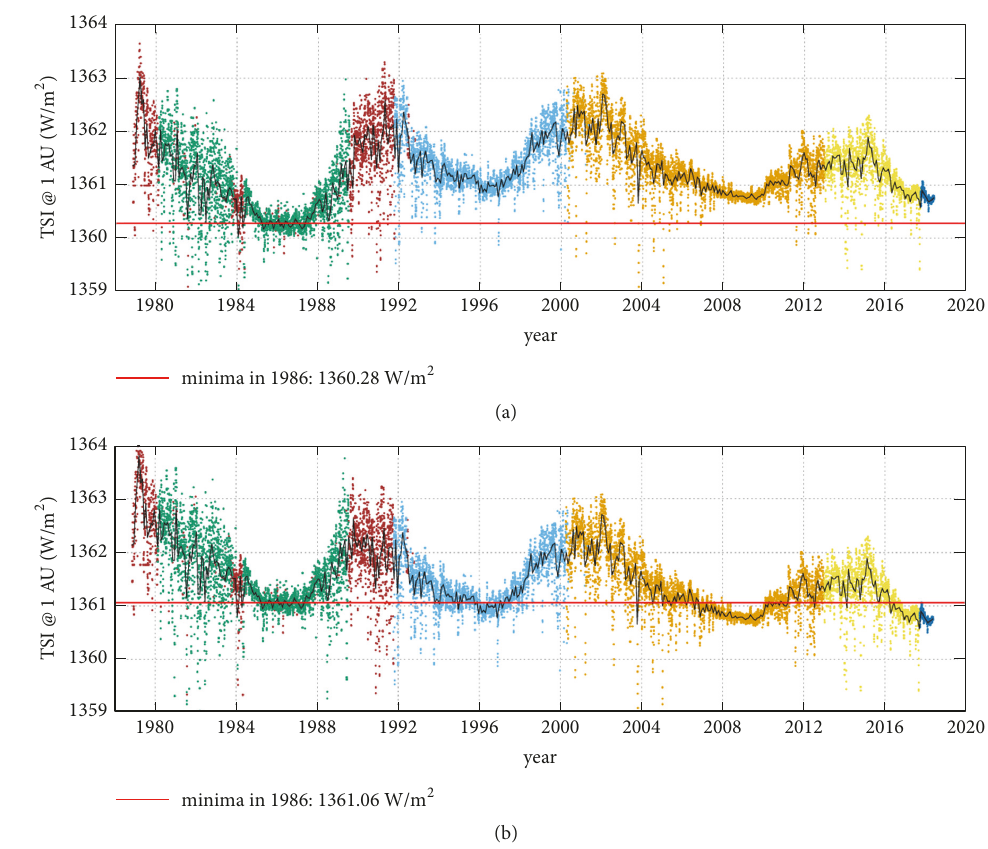
Figure 7: Updates of the TSI composites proposed in Willson and Mordvinov [3], Scafetta [6], and Willson [7]. (a) Unaltered Nimbus7/ERB data are used during the ACRIM-Gap; (b) Nimbus7/ERB data are altered to agree with the ERBS/ERBE trending during the same period. Data from Nimbus7/ERB (brown), ACRIM1 (green), ACRIM2 (cyan), ACRIM3 (orange), VIRGO (yellow), and TIM